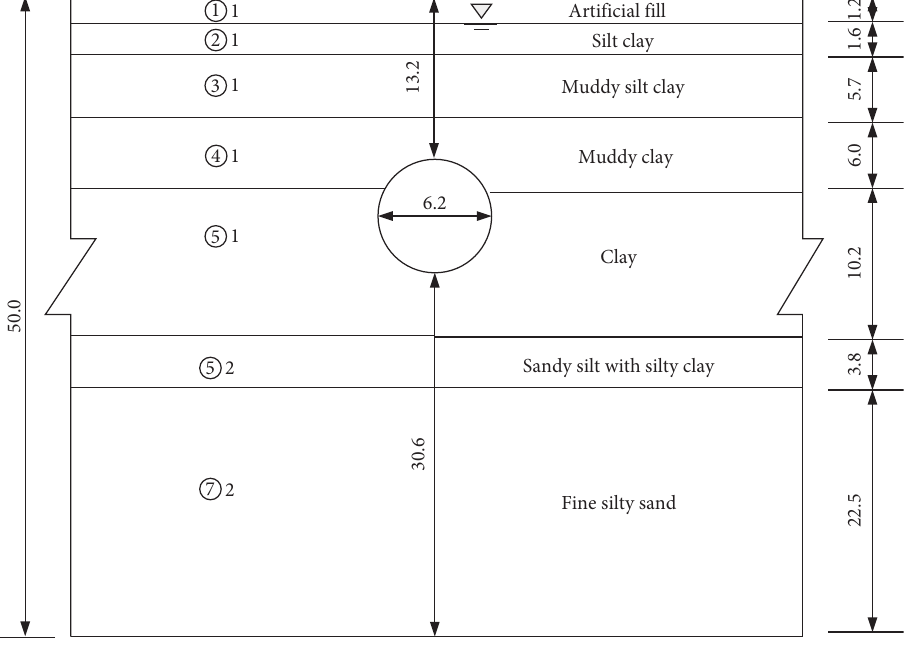
Figure 2: Soil profile at the measured site (unit: